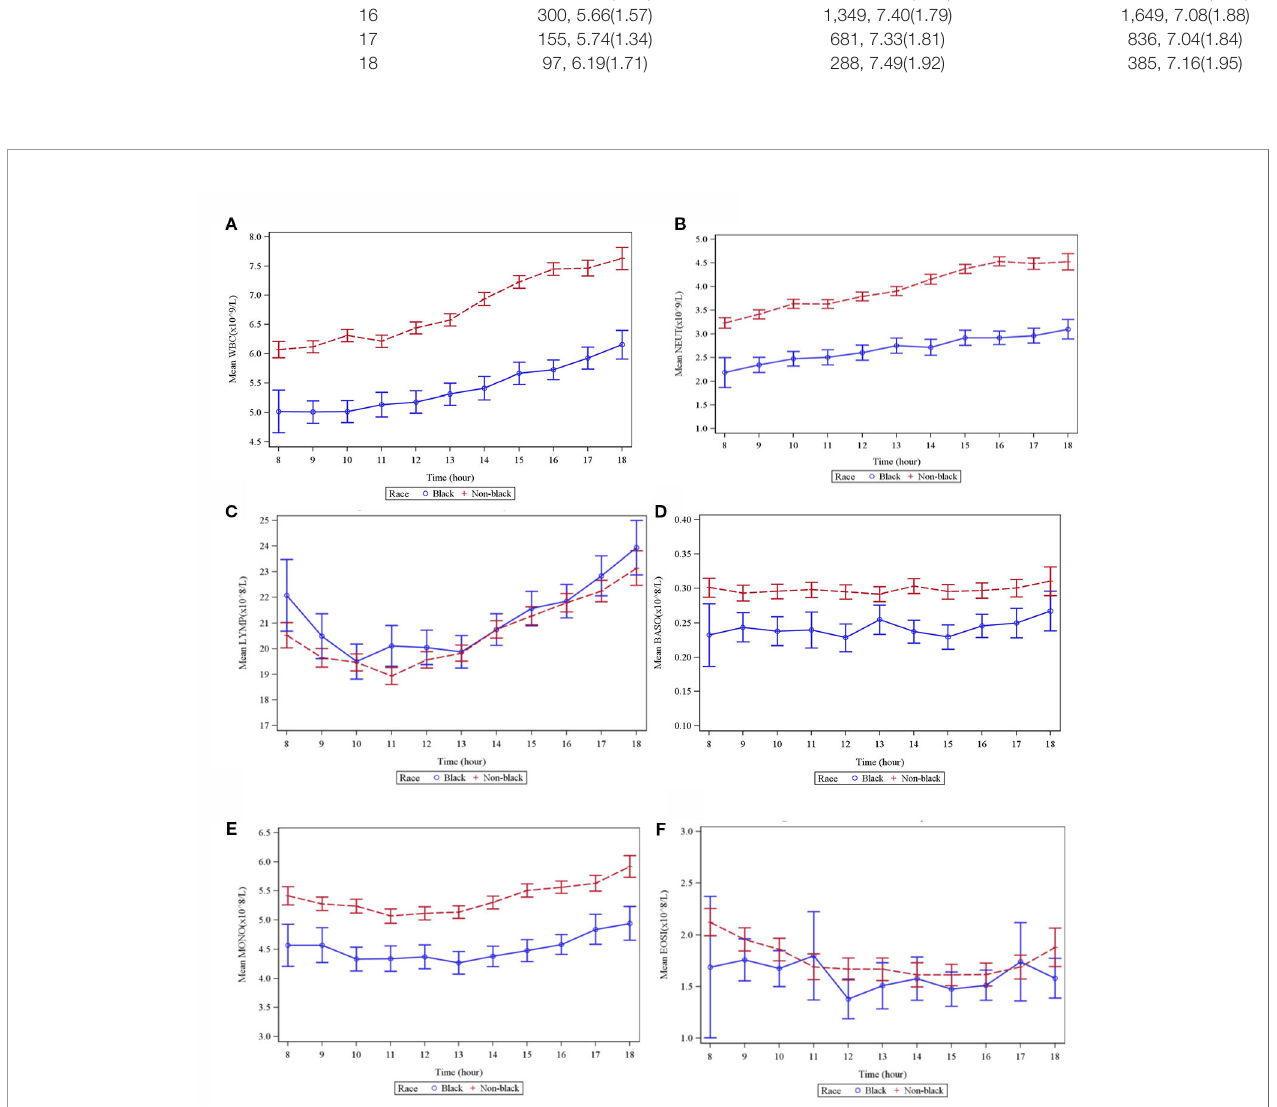
FIGURE 1 | Graphs showing means of different WBC types by time and race. (A) Total WBC. (B) Neutrophils. (C) Lymphocytes. (D) Basophils. (E) Monocytes. (F)